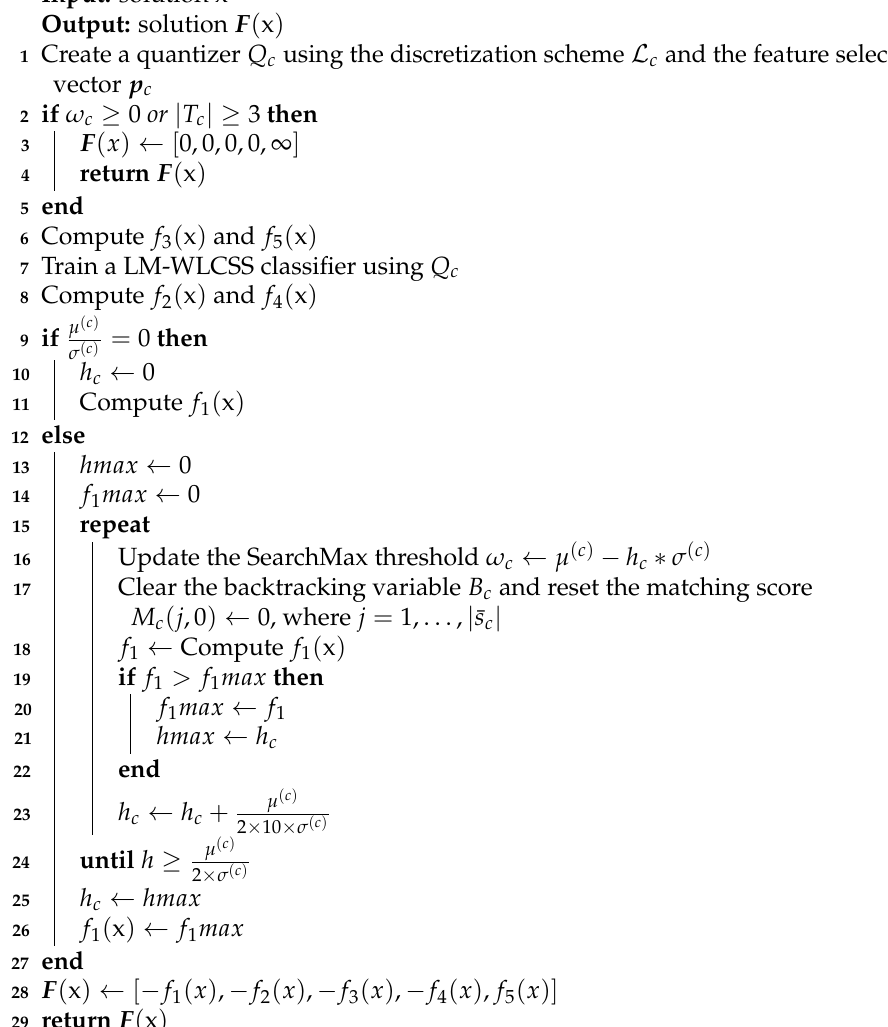
Algorithm 2: Solution